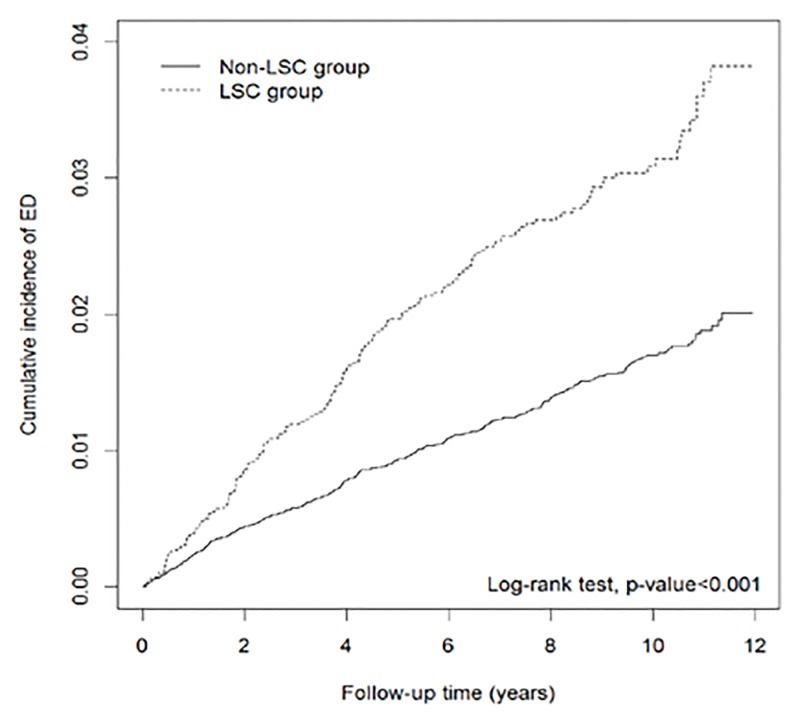
Cumulative incidence curves of ED for LSC and non-LSC groups.Abbreviation: LSC, lichen simplex chronicus; ED, erectile dysfunction.